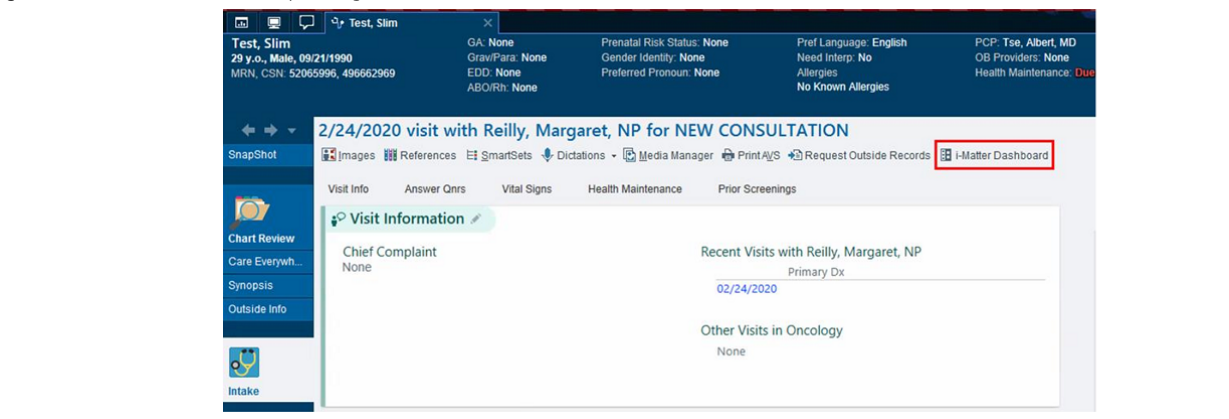
Figure 3. Screenshot of i-Matter Epic